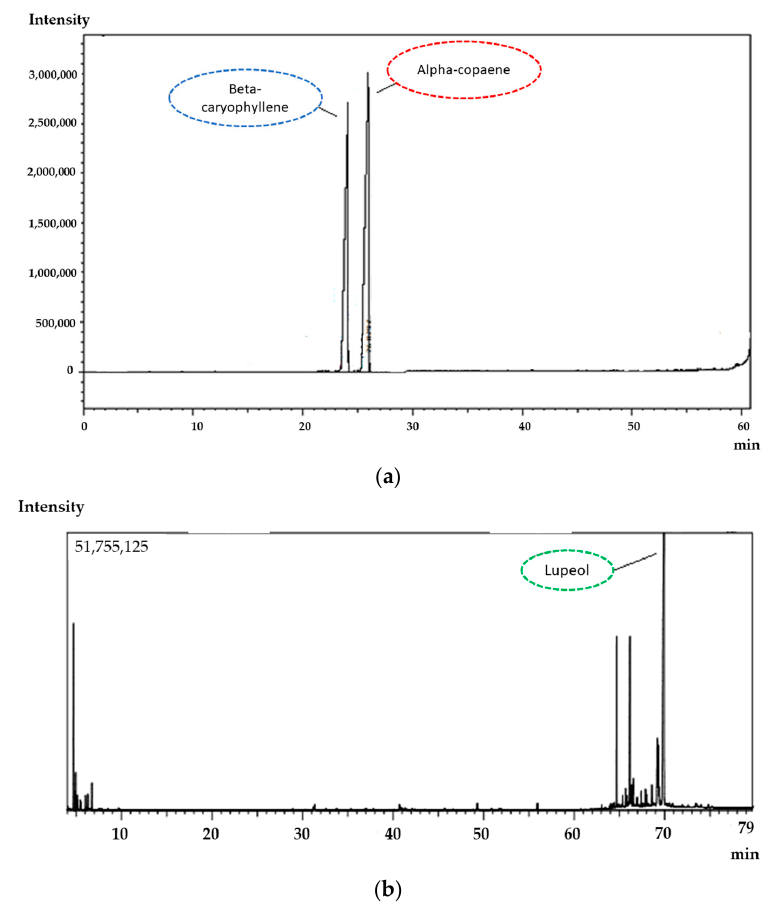
Figure 1. Chromatographic profile of the CP ( a ) and extract ( b ) by CG highlighted the major components, alpha-copaene, beta-caryophyllene and lupeol.